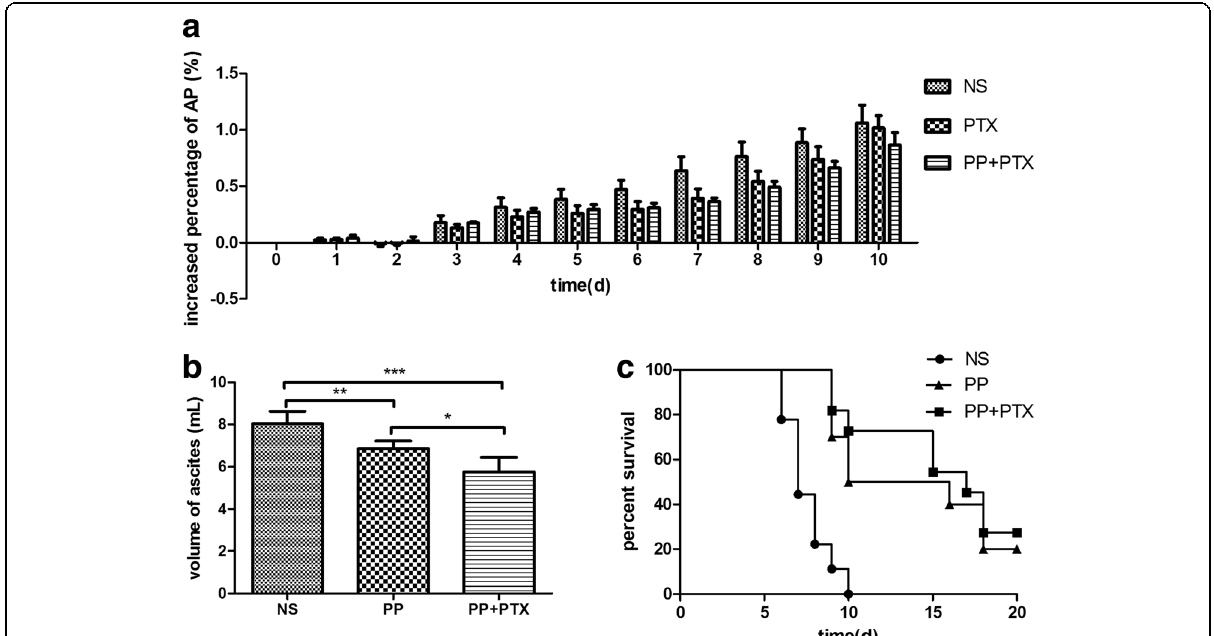
Fig. 10 The anti-tumor effect of PP/PTX in H22 tumor-bearing mice. a Balb/C mice ( n = 5) were intraperitoneally injected with PP/PTX or PTX at day 3. b Ascites of each group ( n = 5) were collected at day 10. c The survival of each group ( n = 10) was observed daily. * P < 0.05, ** P < 0.01, *** P <